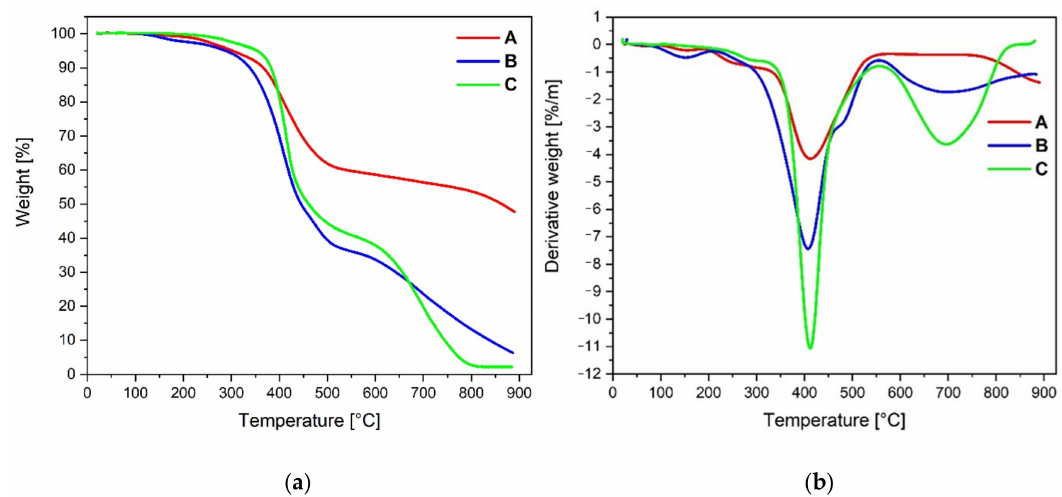
Figure 4. TGA ( a ) and DTG ( b ) curves for A – C